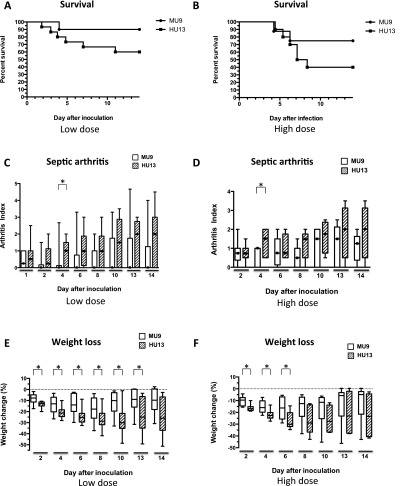
Predicted toxicity correlates with disease severity in vivo. Using high and low doses (7.8–8.0 and 3.7–4.1 × 107 CFU, respectively), mice were inoculated intravenously with the high and low toxic isolates (HU13 and MU9, respectively), and survival of the mice, the development of septic arthritis, and weight loss were recorded as indications of disease severity. In each case the highly toxic HU13 isolate caused the most severe disease symptoms. (A) n = 10–15. (B) n = 8–10. (C) n = 10–20. (D) n = 10. (E) n = 10–19. (F) n = 10. Significant P-values (<0.05) are indicated (*).